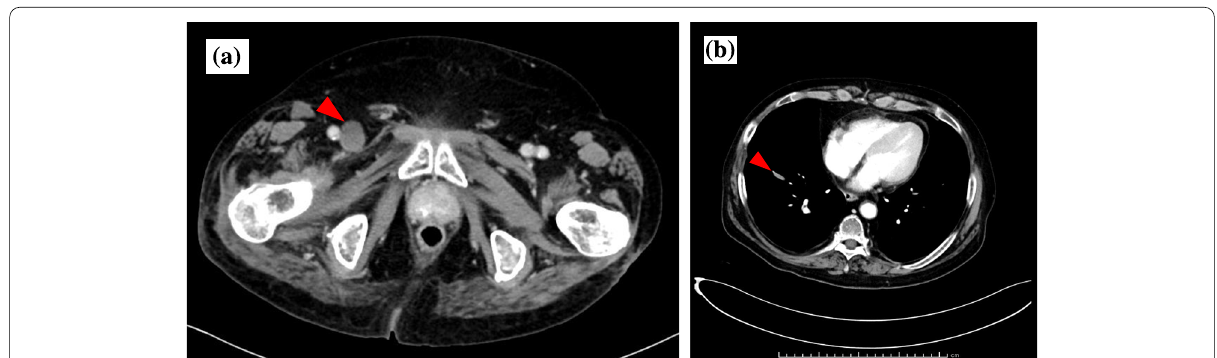
Fig. 2 Computed tomographic images. Computed tomography revealed a thrombosis in the common iliac vein, causing dilation and occlusion of the vein, and b micro-thromboembolism in the pulmonary artery within the right lower